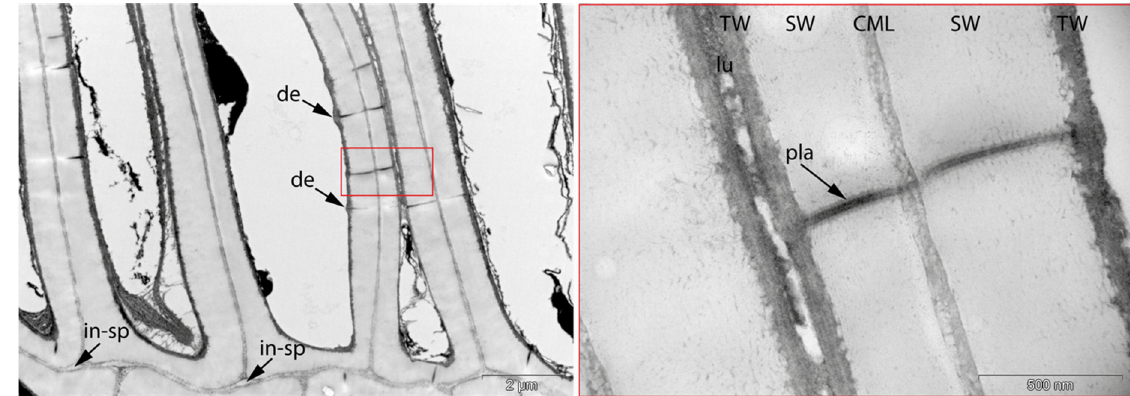
Figure 12. Reference sample. TEM images of thick-walled cell of lenticel with plasmodesmata (pla) in tangential wall and intercellular spaces (in-sp) in radial cell corners. Tubular plasmodesmata are filled and occasionally have a deposit (de) towards the cell lumen.